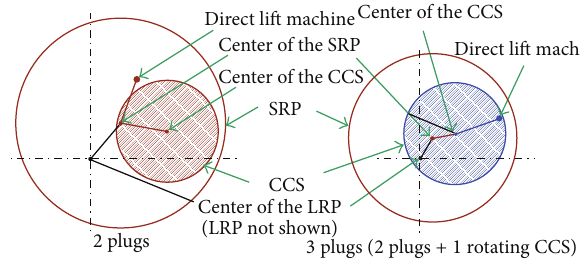
Figure 9: Two plugs/three plugs kinematics comparison.